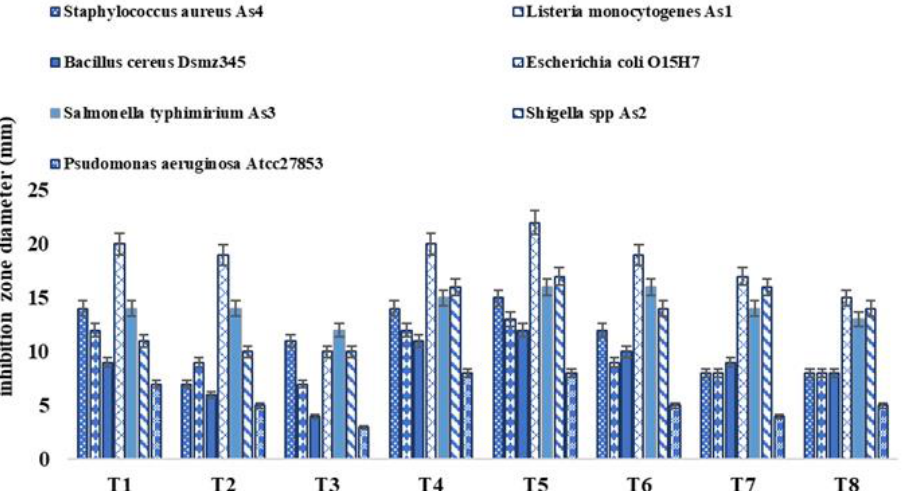
Figure 1. Antimicrobial activity of fermented soymilk against pathogenic bacteria. T1 (L. plantarum ATCC14917), T2 ( Lc. thermophilus DSM20259), T3 ( B. longum B41409), T4 ( L. plantarum ATCC14917 + Lc. thermophilus DSM20259), T5 (L. plantarum ATCC14917 + Lc. thermophilus DSM20259 + B. longum) , T6 ( L. plantarum ATCC14917 + L. casei DSM20011 + Lc. thermophiles DSM20259), T7 ( L. casei DSM20011 + L. acidophilus ATCC20552 + Lc. thermophilus DSM20259), and T8 ( L. acidophilus ATCC20552